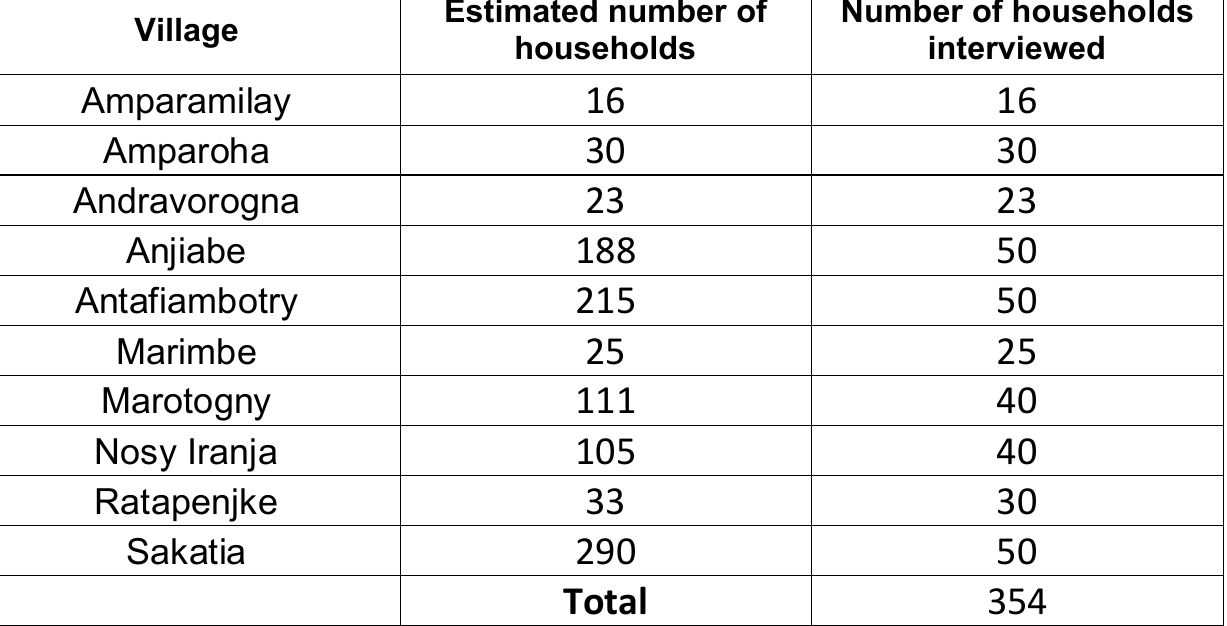
Appendix 2 . Proportion of households surveyed and total estimated number of households in each